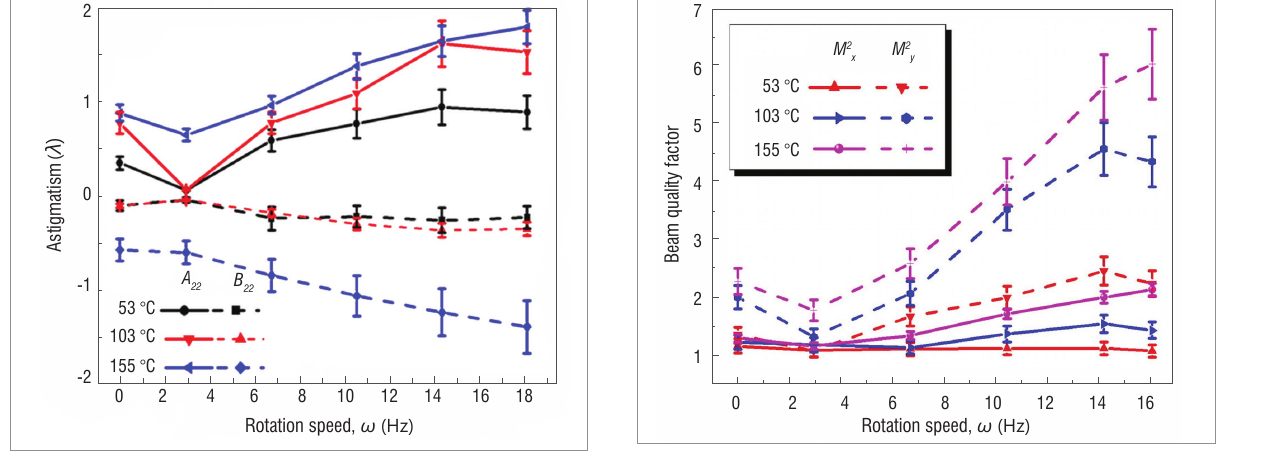
Figure 8: Boundary layer beam quality factor of the laser beam at selected wall